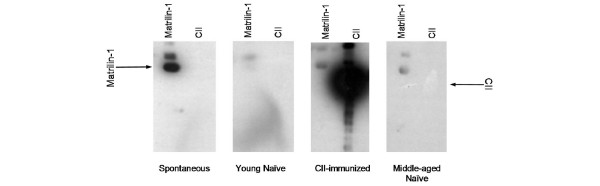
Matrilin-1-specific IgG present during spontaneous polychondritis in DQ6α8β transgenic mice. Representative sera from middle-aged mice displaying spontaneous polychondritis, from young naïve mice, from young mice with type II collagen (CII)-induced polychondritis or from middle-aged mice not displaying clinical disease were separated by SDS-PAGE electrophoresis and were blotted for the presence of matrilin-1-specific or CII-specific IgG. Although minor levels of matrilin-1-specific IgG were detectable in each sera that increased with age, it was highly elevated in each spontaneous polychondritis mouse examined. CII-specific IgG was only detected in the CII-immunized mouse, as also observed by ELISA.